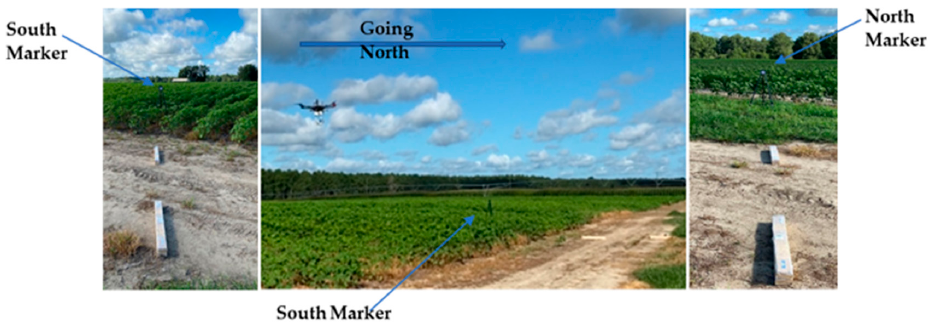
Figure 8. Illustration of aircraft flight path with tags in the